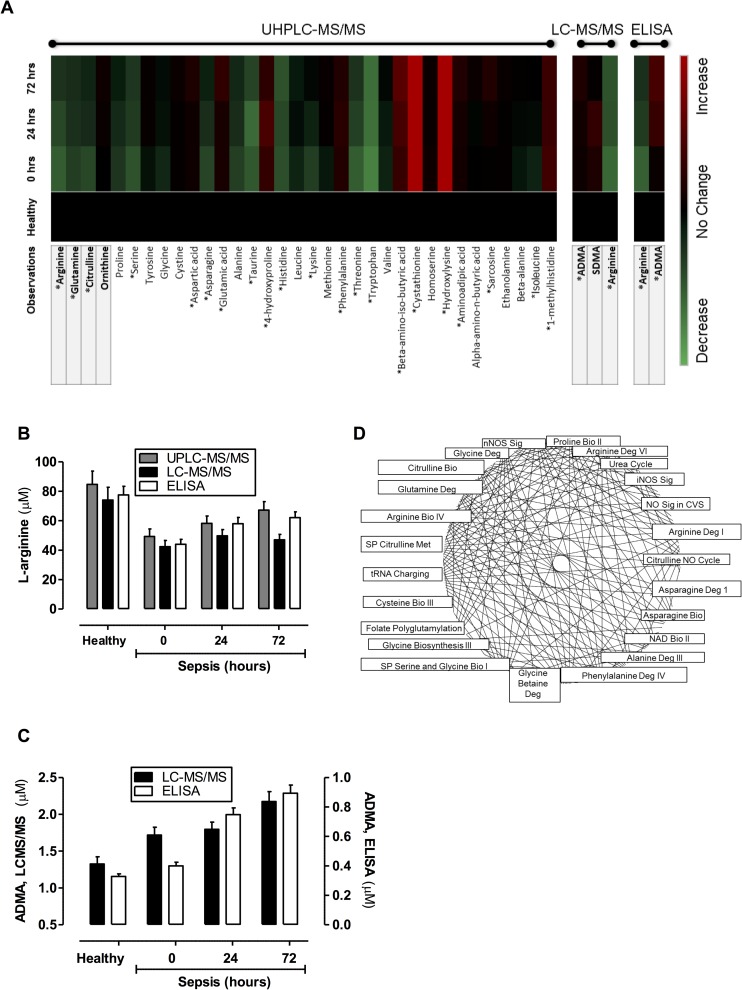
Targeted metabolic profiling of amines and methylarginines in human plasma from healthy donors and patients with sepsis.Amine and methylarginine levels were measured using (A) UHPLC-MS/MS, LC-MS/MS and/or ELISA in the plasma of healthy donors and patients with sepsis at diagnosis (0 hours), 24 hours and 72 hours post diagnosis. Comparisons between levels of L-arginine from (B) UHPLC-MS/MS, LC-MS/MS and ELISA and (C) ADMA from LC-MS/MS and ELISA are shown at diagnosis (0 hours), 24 hours and 72 hours, post diagnosis. (D) Canonical pathways extracted from IPA software were based on an input of read outs comparing plasma levels of amines in healthy donors and patients with sepsis as a ratio. Data are ± SEM for n = 21 healthy donors and n = 38 patients with sepsis. Data was analysed by one-way ANOVA with Dunnett’s post-hoc test and Benjamini-Hochberg test with a false discovery rate of 0.05; *p<0.05.